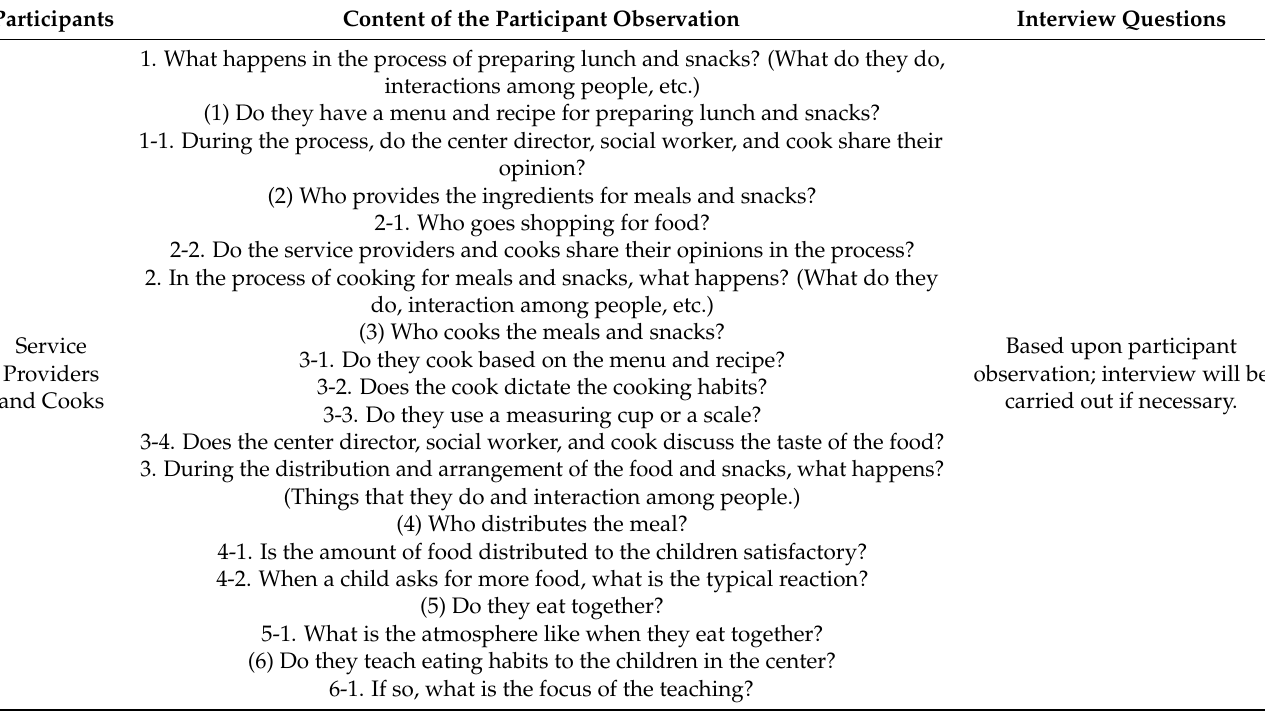
Table A2. Content of the participant observation and interview